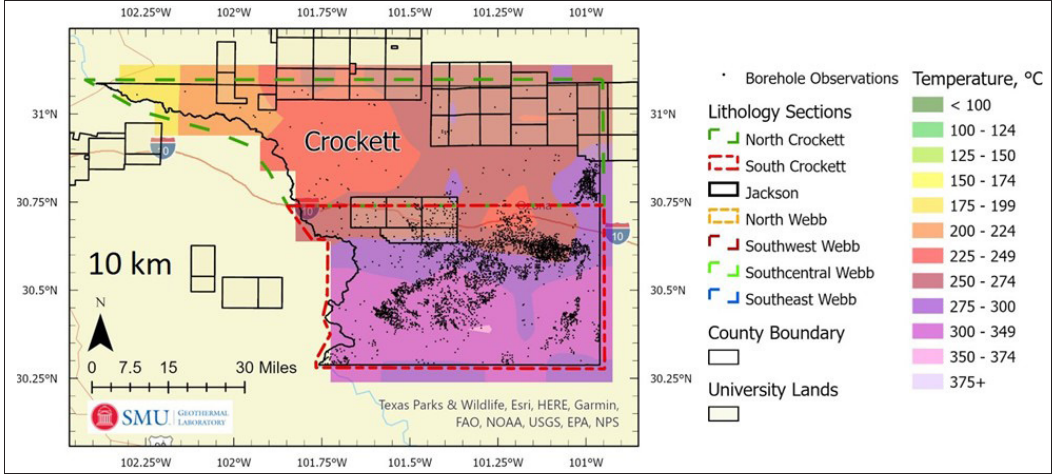
Figure 7. Crockett County temperature at 10 kilometers (km; 32,800 feet), with surface well locations displayed as small black dots. While data sites are displayed on this map, there are no direct temperature measurements at this depth. The modeled temperatures reach greater than 300 °C in the south.